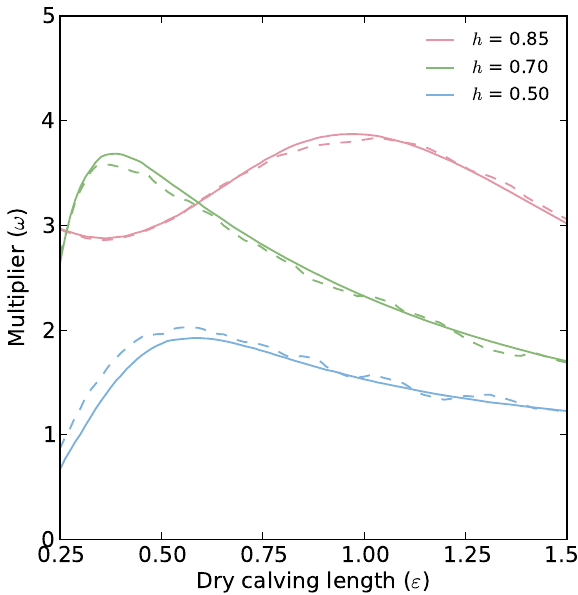
Fig. 6. The effect of surface damage on the ω − ε relationship. Dashed lines show the relationship when an enhancement factor is applied to the upper layers. No discernible pattern is visible, and the difference is likely to be a numerical artifact.